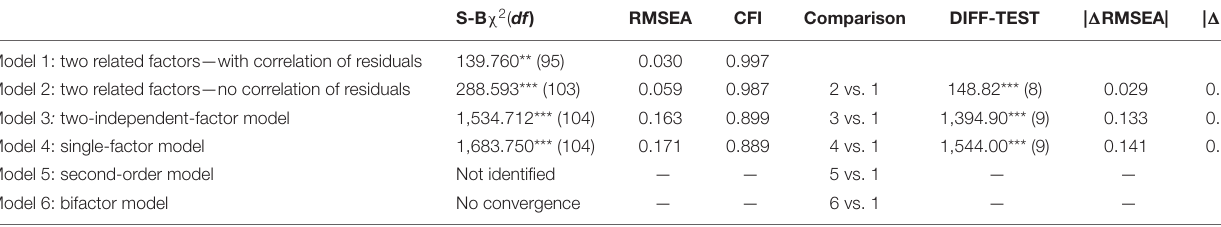
TABLE 3 | Model comparison.